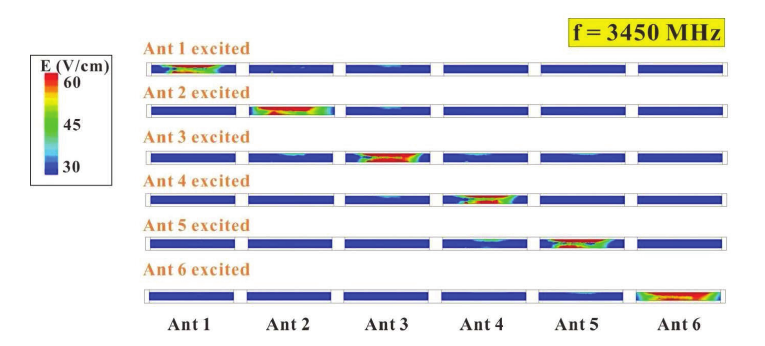
Figure 18. Simulated electronic field distribution of the six-antenna system at 3450 MHz.